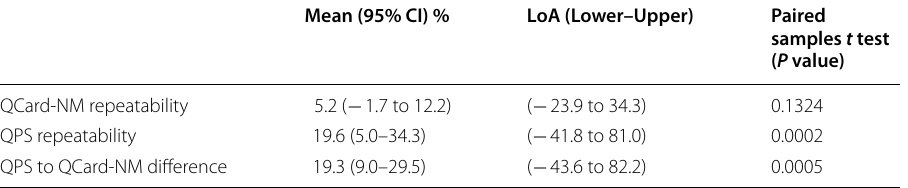
Table 3 The quantitative values of Bland–Altman